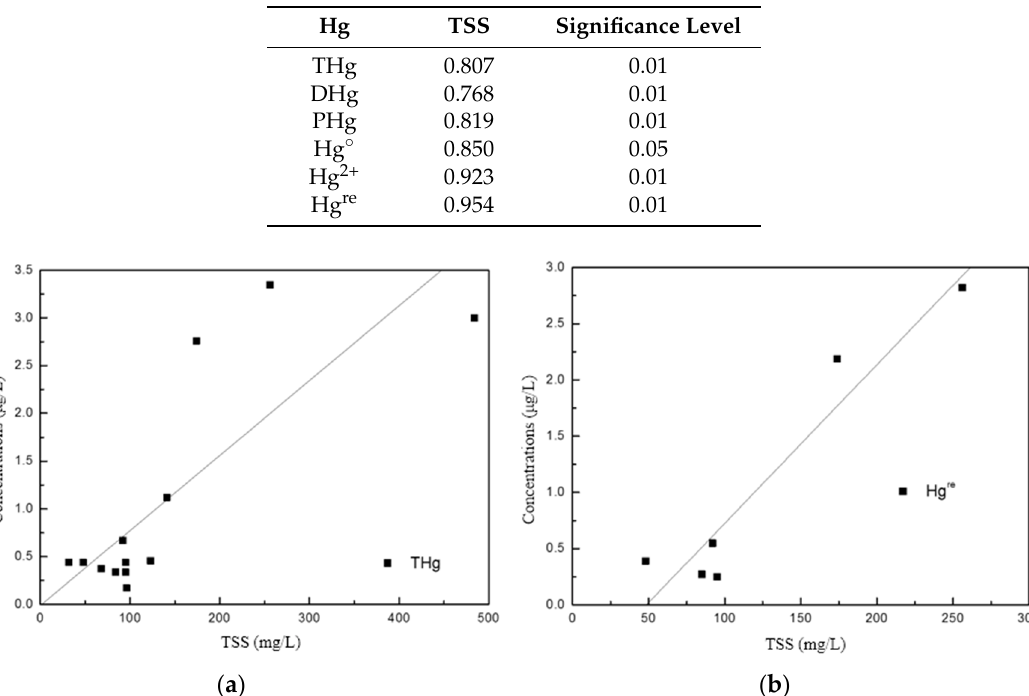
Figure 3. Correlation between TSS and Hg: ( a ) total Hg vs. TSS; and ( b ) residual Hg vs. TSS.